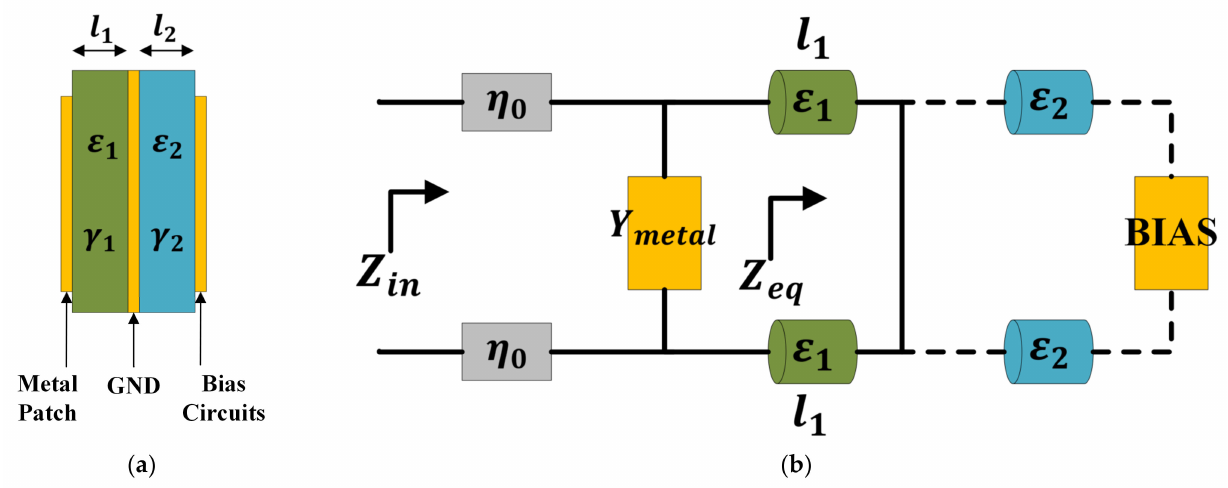
Figure 1. ( a ) Side view of the multi-substrate layer MSRRA. Each substrate medium is characterized by its thickness l x , permittivity ε x , and propagation constant γ x . ( b ) Transmission line-based EC model of a multi-substrate layer MSRRA. The metal patch is represented by a shunt